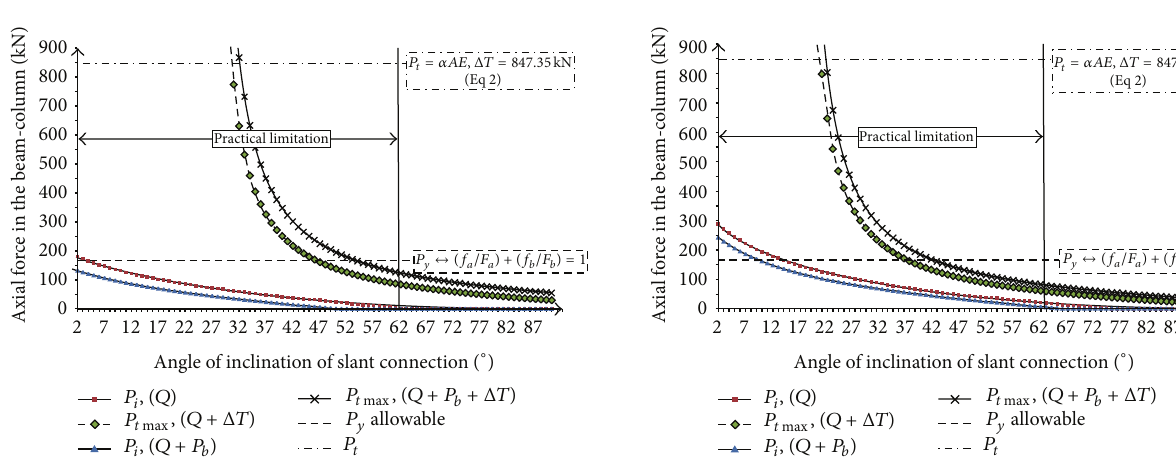
Figure 17: Relation between axial force in the beam with slope of slant connection ( 𝜃 ∘ ) due to nonsymmetric gravity load and elevated temperature (friction factor, 𝜇 𝑠 = tan 𝜑 = 0.5 ) (Δ𝑇) = 50 ∘ C.